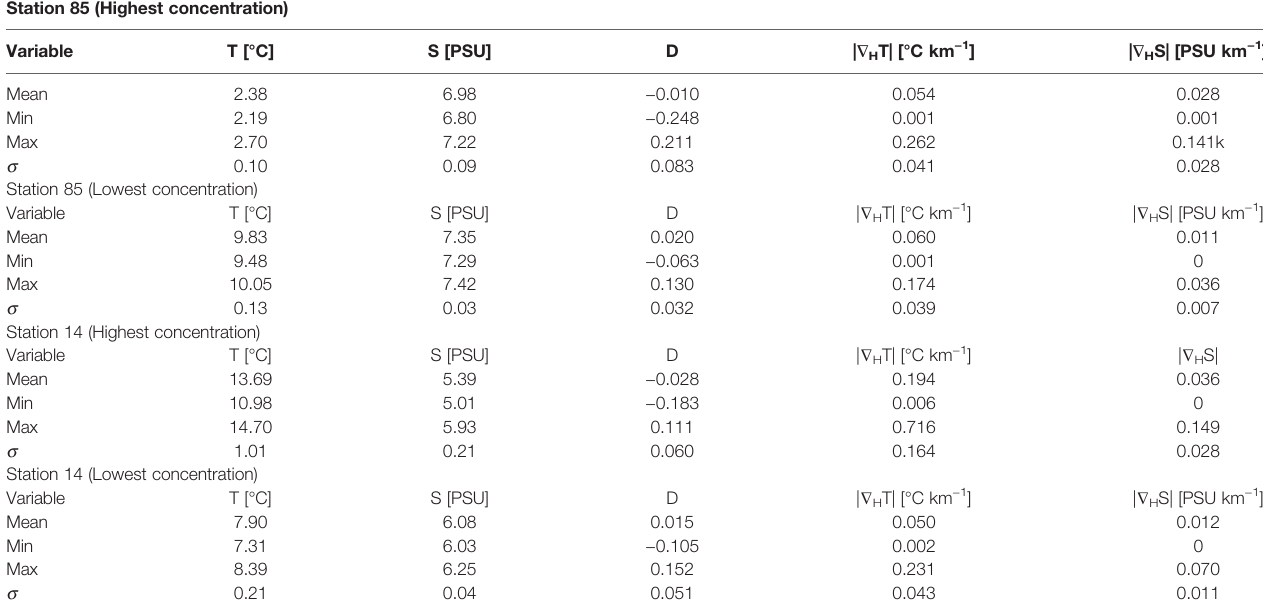
TABLE 2 | Statistical values of different surface parameters around the monitoring stations during the observed highest and lowest value of MPs. Station 85 (Highest concentration)